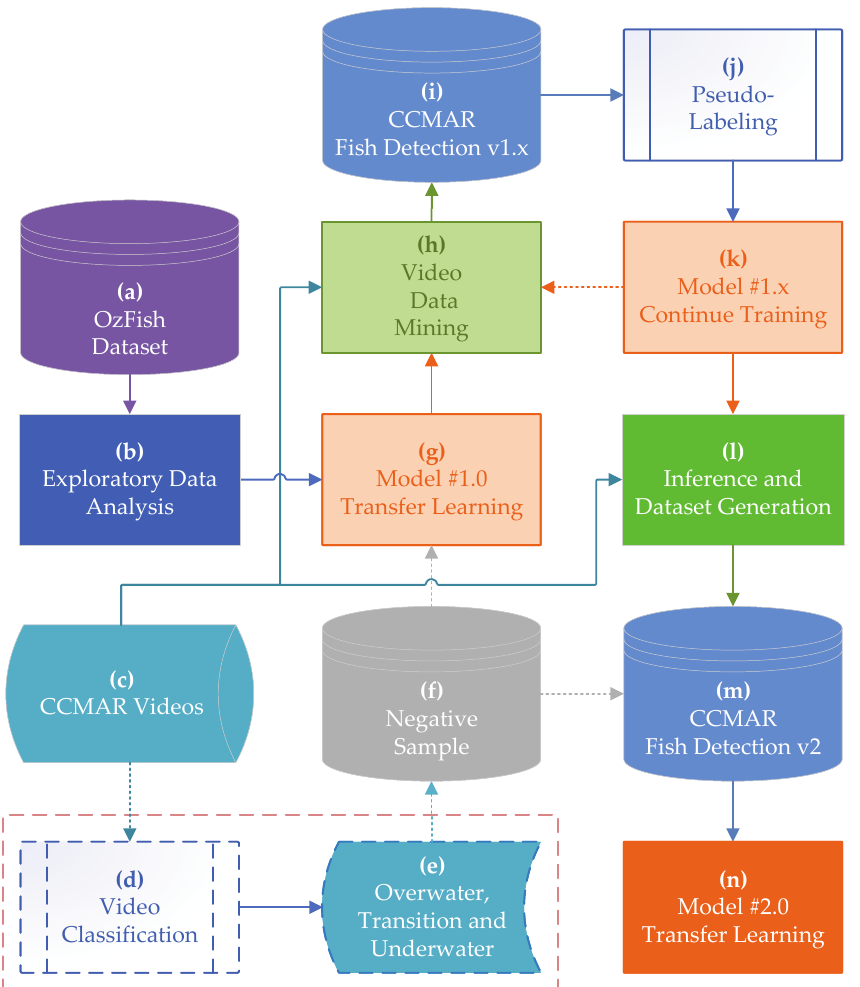
Figure 4. Overall pipeline of the proposed method. Each stage is identified by ( ∗